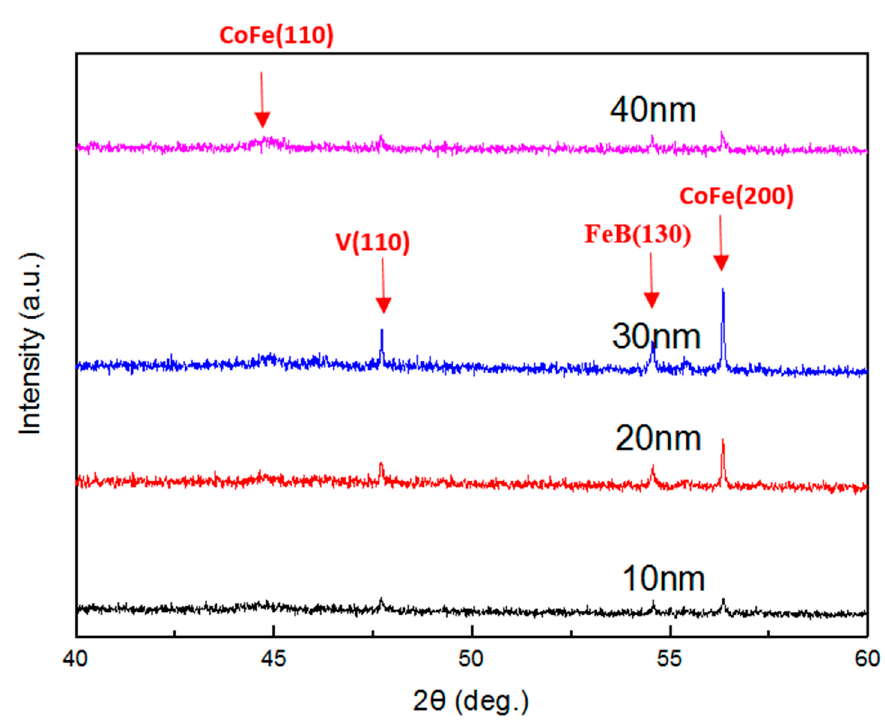
Figure 1. X-ray di ff raction patterns of the Co 40 Fe 40 V 10 B 10 Figure 1. X-ray diffraction patterns of the Co 40 Fe 40 V 10 B 10 films.